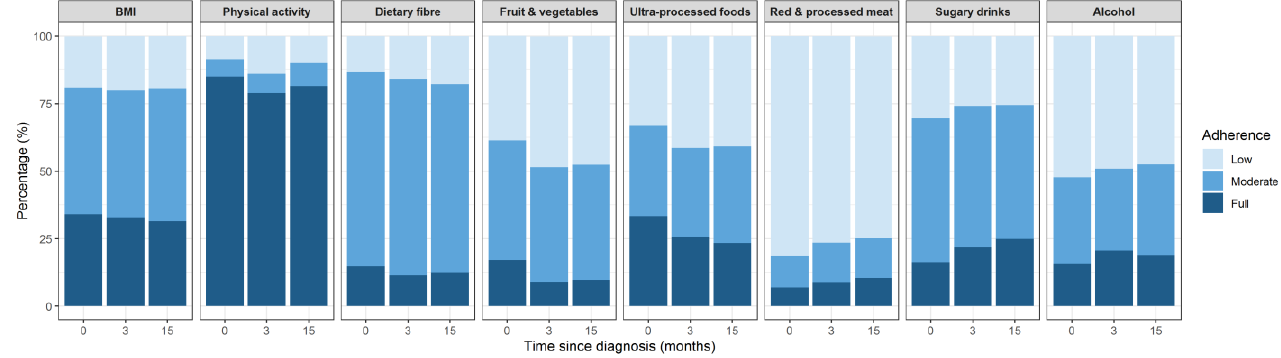
Figure 2. Adherence to the 2018 World Cancer Research Fund/American Institute for Cancer Research (WCRF/AICR) lifestyle recommendations at baseline, three months and fifteen months after diagnosis in 935 patients with non-muscle invasive bladder cancer.